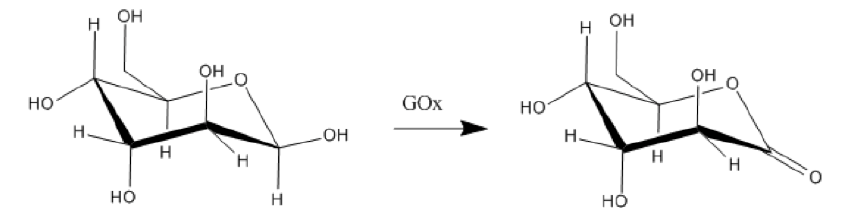
Figure 8. ( A ) Glucose oxidation to gluconolactone catalyzed by glucose oxidase